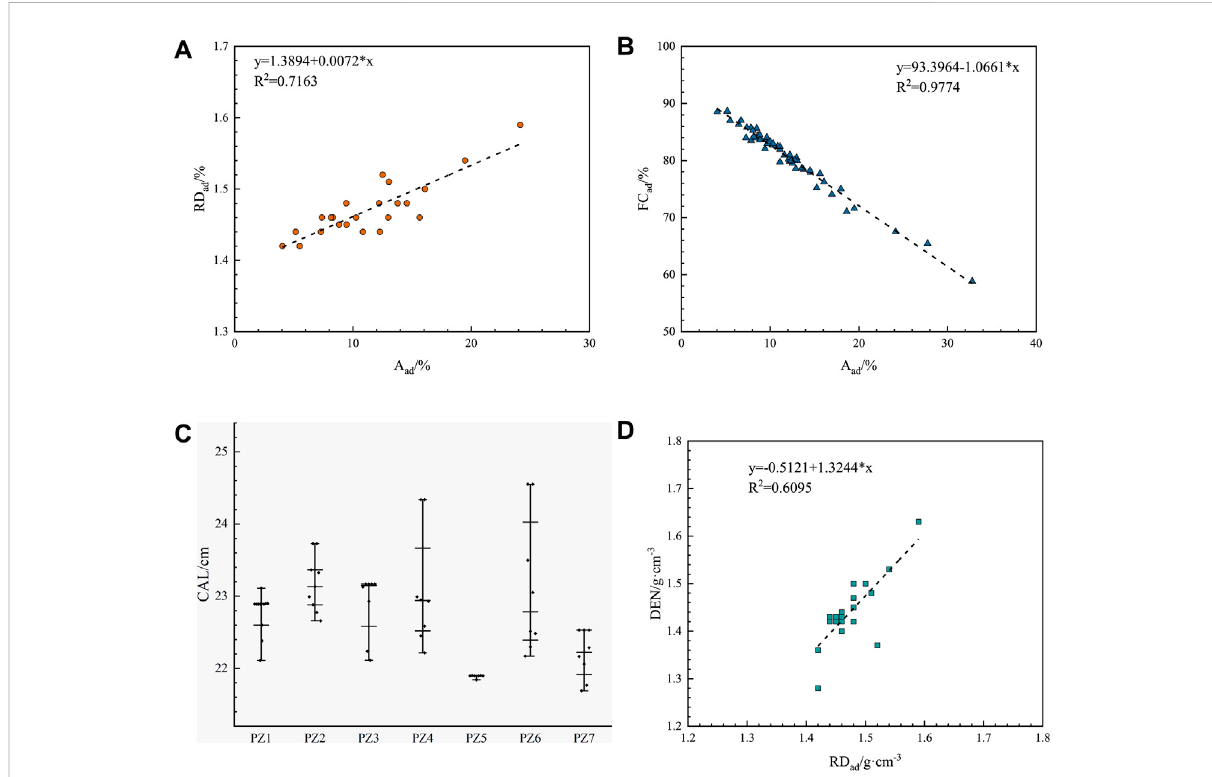
FIGURE 3 Pre-processing and quality checking of experimental data and geophysical logging processing of coal samples. (A) Correlation analysis plot of theA ad contentandRD ad . (B) CorrelationanalysisplotoftheA ad content and theFC ad content. (C) Dilationofcore drilling. (D) Correlation analysisof the pre-processed DEN curve response values with the RD ad of the laboratory coal samples.